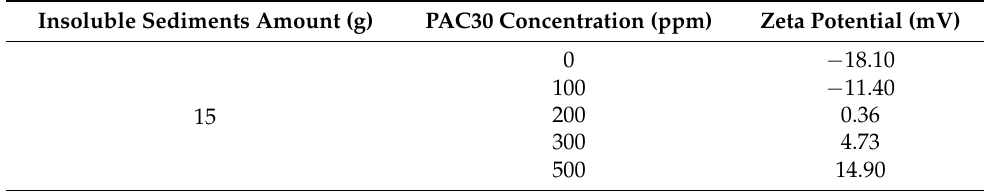
Table 5. Zeta potential values of insoluble sediments after adding different concentrations of PAC30 solution.